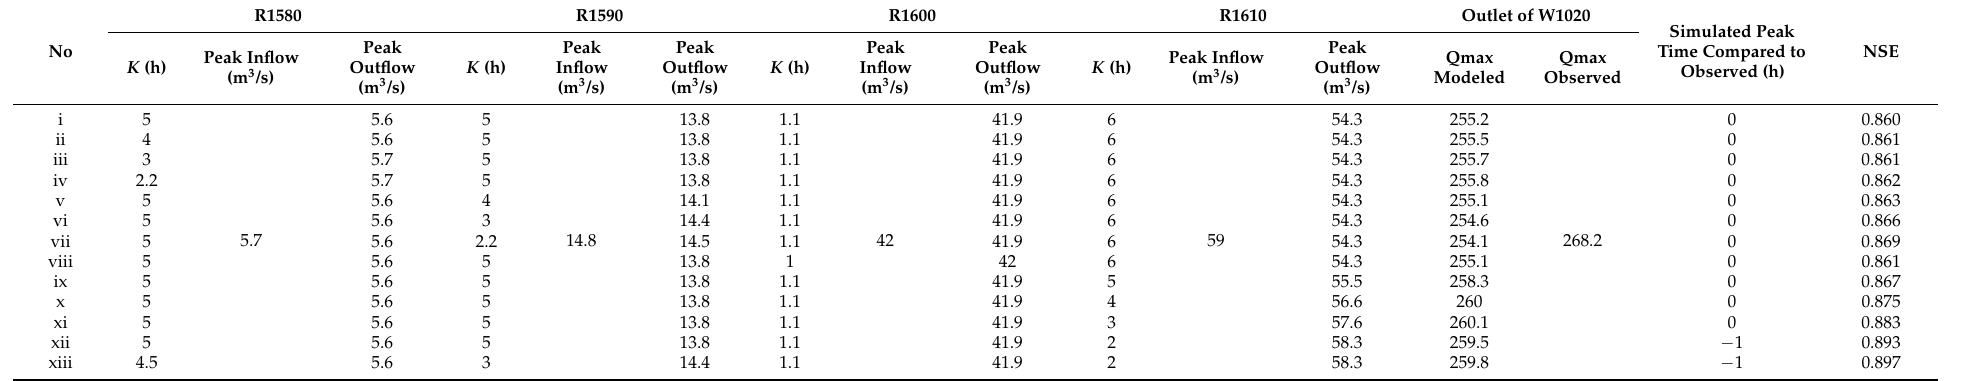
Table 11. Muskingum K (h) calibration for the channels R1580, R1590, R1600 and R1610 to achieve model verification at the exit of the sub-basin